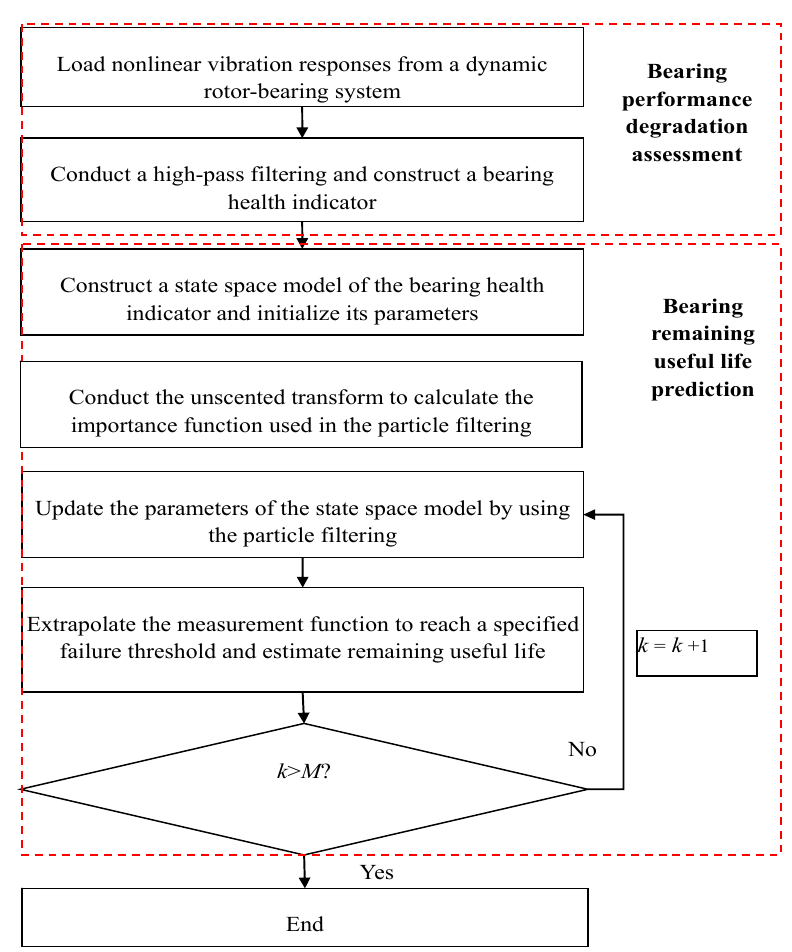
Figure 1. A flowchart of the proposed bearing prognostic method for prediction of bearing remaining useful life (RUL).